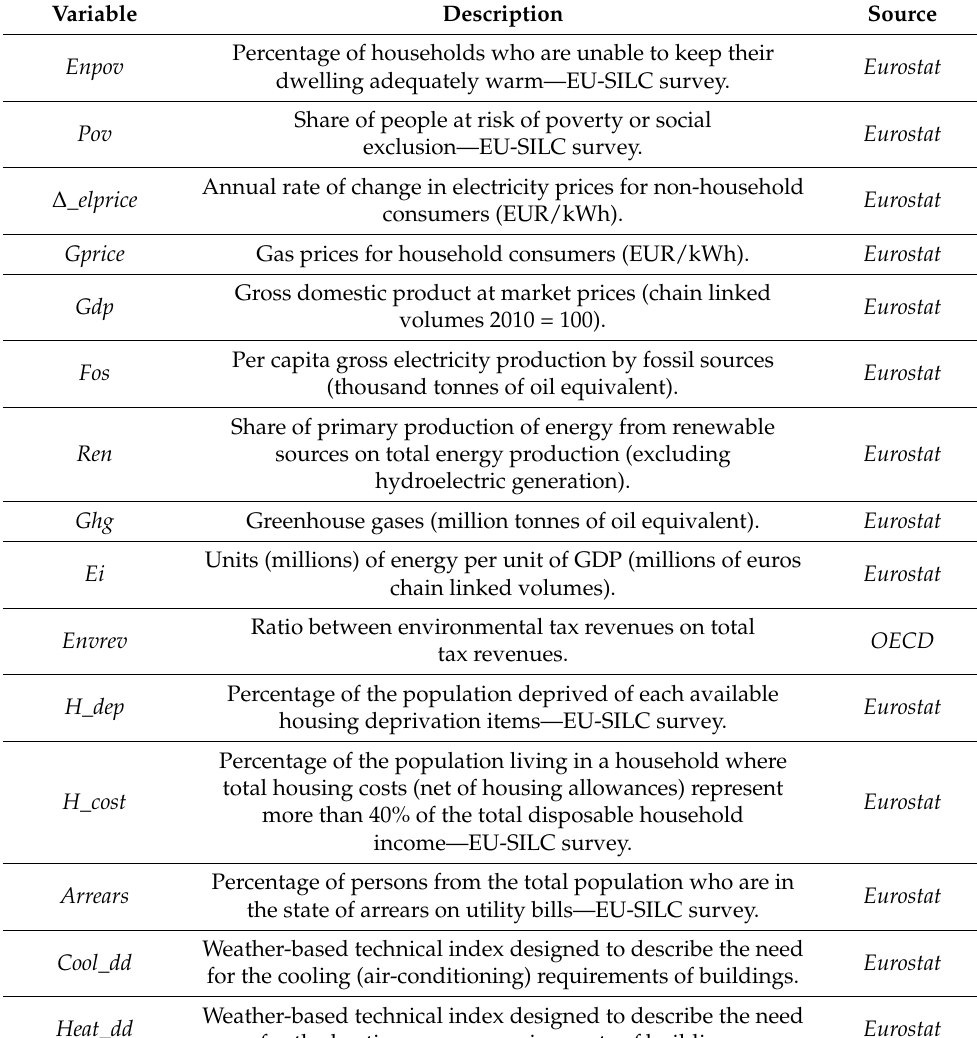
Table 1. Variables